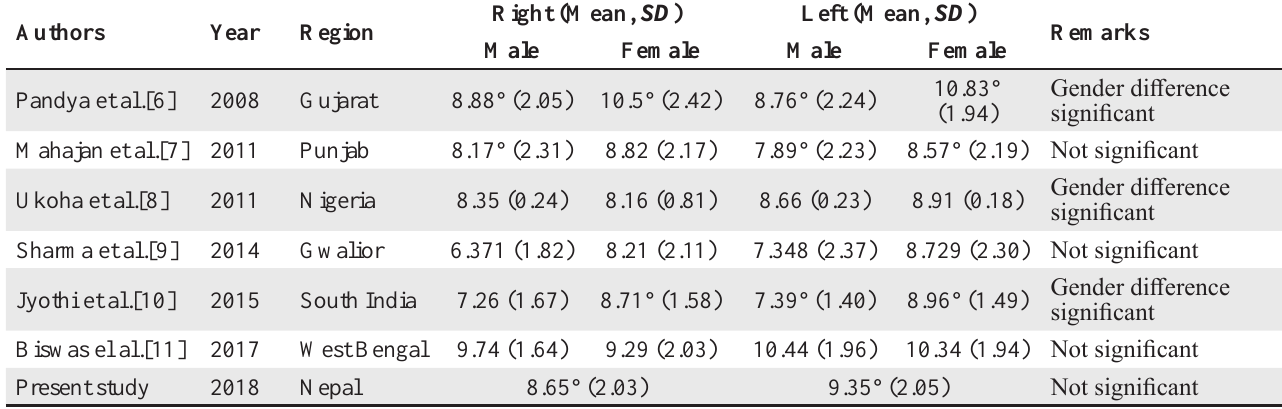
Table 3 : Comparison of mean bicondylar angle from different studies